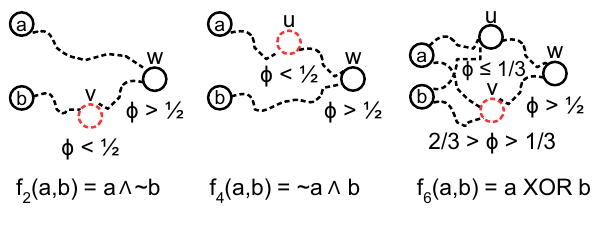
Figure 5. Motifs for non-monotone functions. Simplest logic motifs to compute non-monotone Boolean functions { f 2 , f 4 , f 6 } (Table 1) in the ALTM at random node u , on seed nodes a , b . Dashed lines represent paths, and dashed nodes are antagonistic. Functions f 13 , f 11 , and f 9 are negations of these, respectively, so have very similar networks, negating each